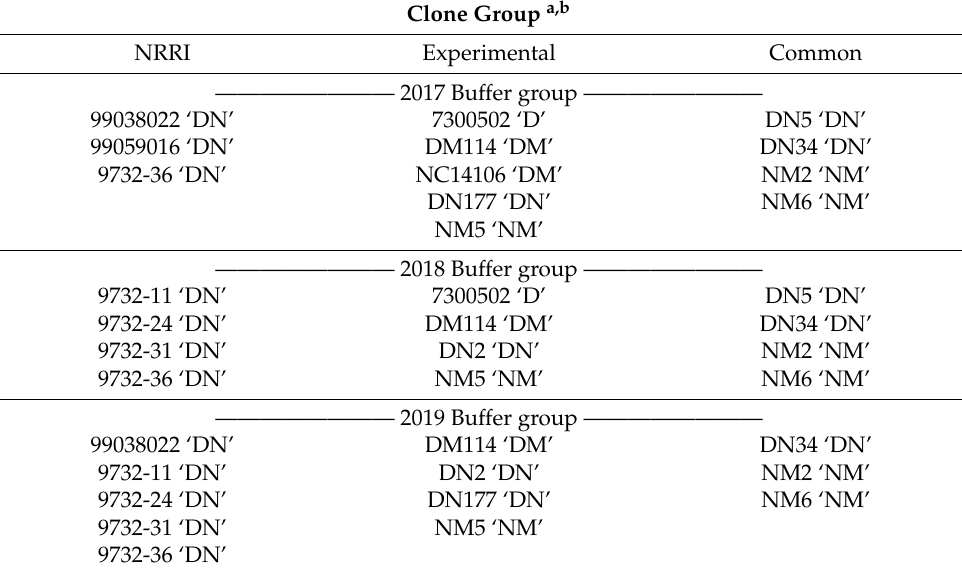
Table 3. Clone groups and buffer groups (i.e., years of planting) of clones and their genomic groups for Populus genotypes tested in a regional phytotechnologies network of sixteen phytoremediation buffer systems (i.e., phyto buffers) established from 2017 to 2019 in the Lake Superior watershed of the Upper Peninsula of Michigan, USA and the Lake Michigan watershed of eastern Wisconsin, USA. Clone Group a,b NRRI Experimental